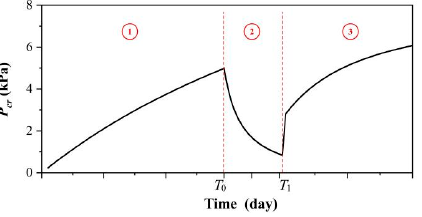
Figure 12. The curve of cracking pressure versus time. The curve could be divided into three parts: ① represents the rest period where the strength grows with time, ② represented the disturbance period where the destroyed structure accounted for strength decrease, and ③ represents the re- 1 (cid:13) represents the rest period where the strength grows with time, 2 (cid:13) represented the disturbance covery period which corresponds to the structure rebuild and strength growth. period where the destroyed structure accounted for strength decrease, and 3 (cid:13) represents the recovery period which corresponds to the structure rebuild and strength